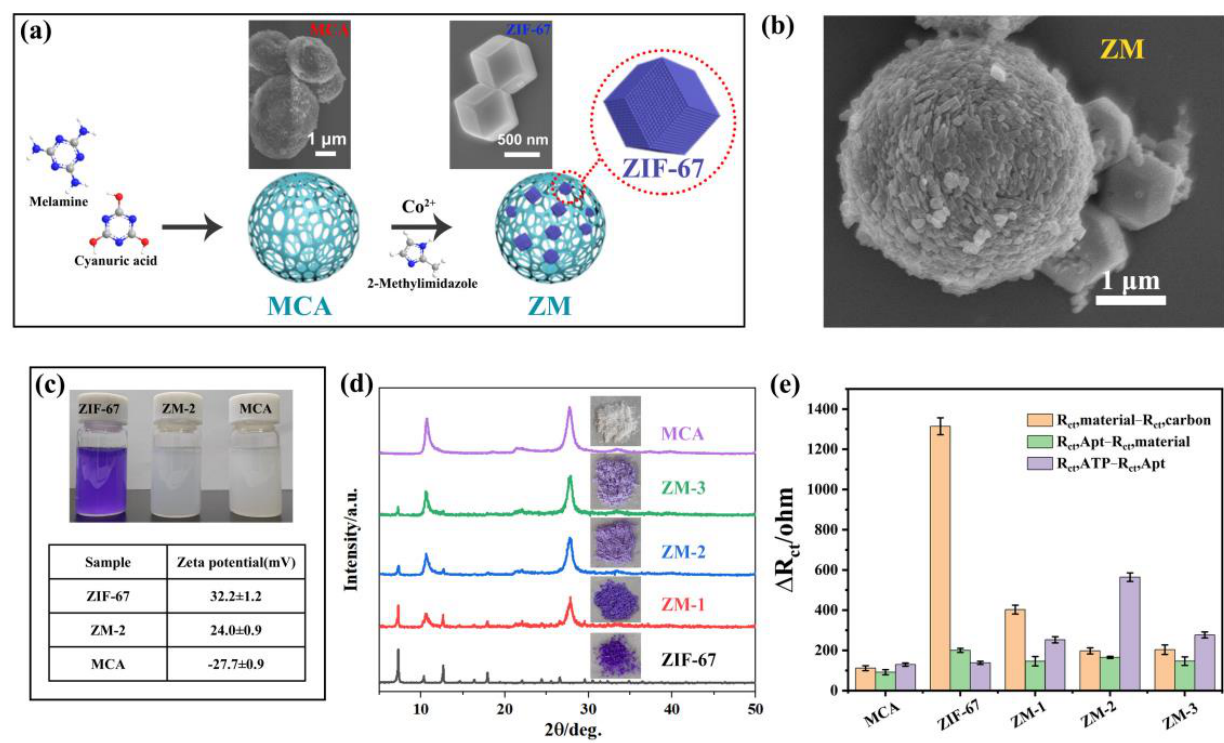
Figure 2. ( a ) Scheme of the synthesis of MCA, ZIF-67, and ZM. Insets are SEM images of MCA and ZIF-67; ( b ) SEM image of the ZM; ( c ) The typical photograph and zeta potential of ZIF-67, MCA, and ZM homogeneous suspension; ( d ) XRD patterns of MCA, ZIF-67, different ZM and their morphologies of powder; ( e ) the R ct value variations of every step of aptasensor fabrication and ATP detection for five materials.